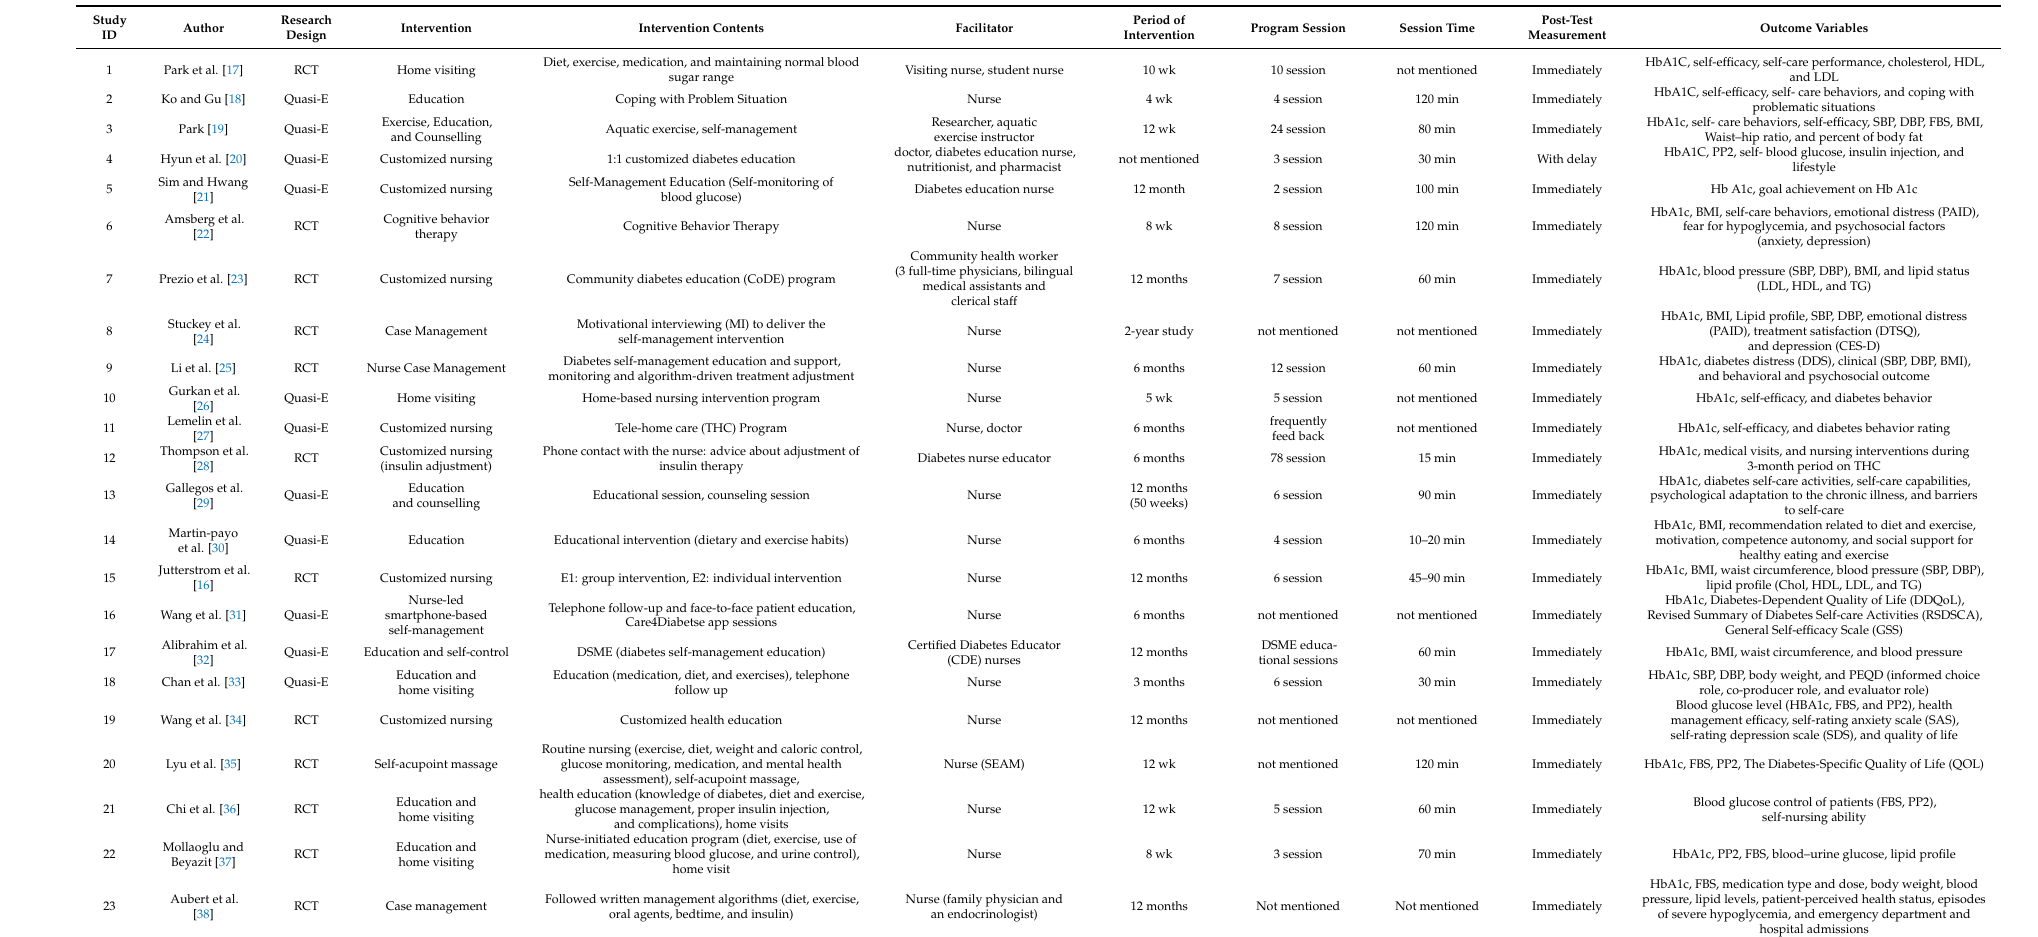
Table 2. Intervention characteristics of the included